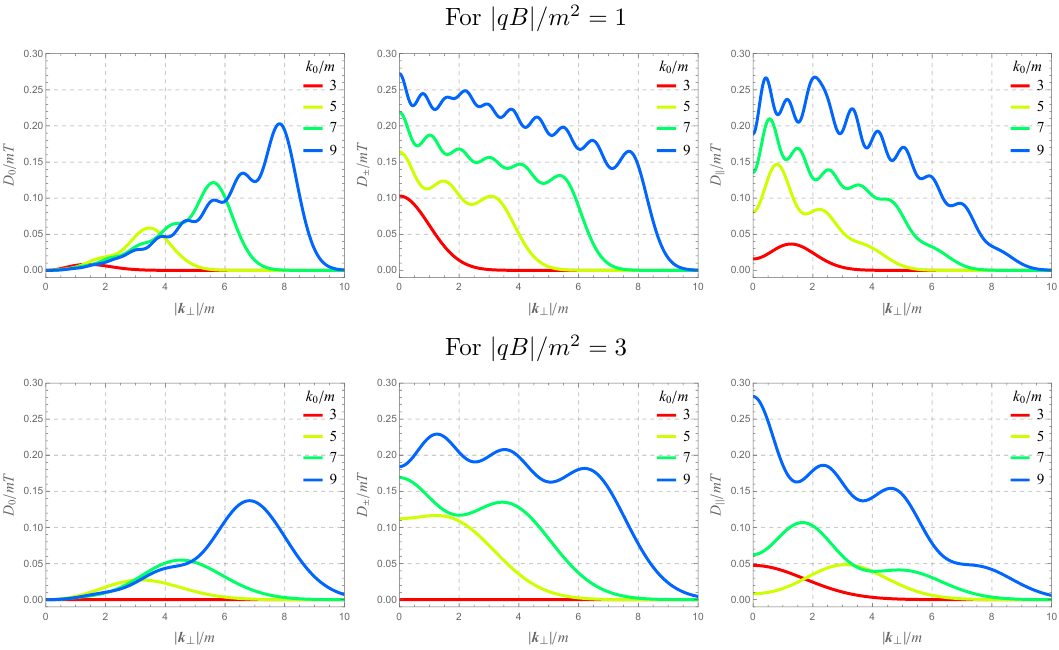
Figure 6 . The photon transverse momentum | k ⊥ | -dependences of the conversion rates summed over the Landau levels D at k = 0 . The lines with different colors distinguish the photon λ z /m energy k = 3 , 5 , 7 , and 9 . The magnetic field strengths are taken as | qB | /m 2 = 1 (top) and = 3 0 /m